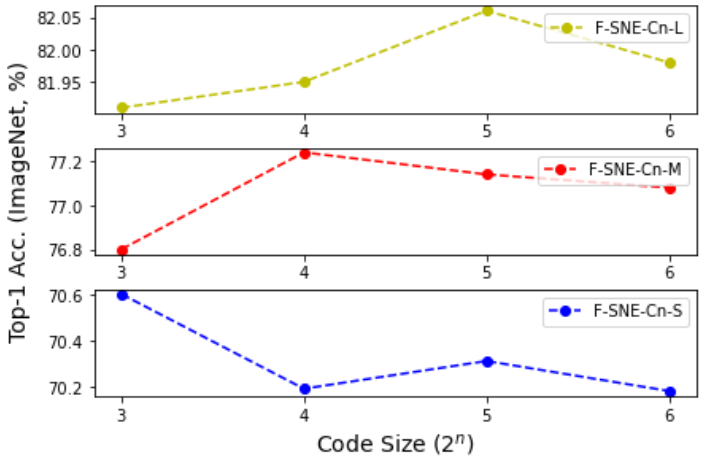
Figure 3. Top-1 accuracies on ImageNet-1k of F-SNE-C n -S, F-SNE-C n -M, and F-SNE-C n -L structures were compared with respect to code sizes from 8 to 64. Results of F-SNE-C n -S, F-SNE-C n -M, and F-SNE-C n -L structures are organized from bottom to top. Table 9. l 2-norms of C q , C k , and C v are extracted from F-SNE-C8-S model according to the trained dataset. The codes exhibit similar l 2-norm values regardless of the dataset.